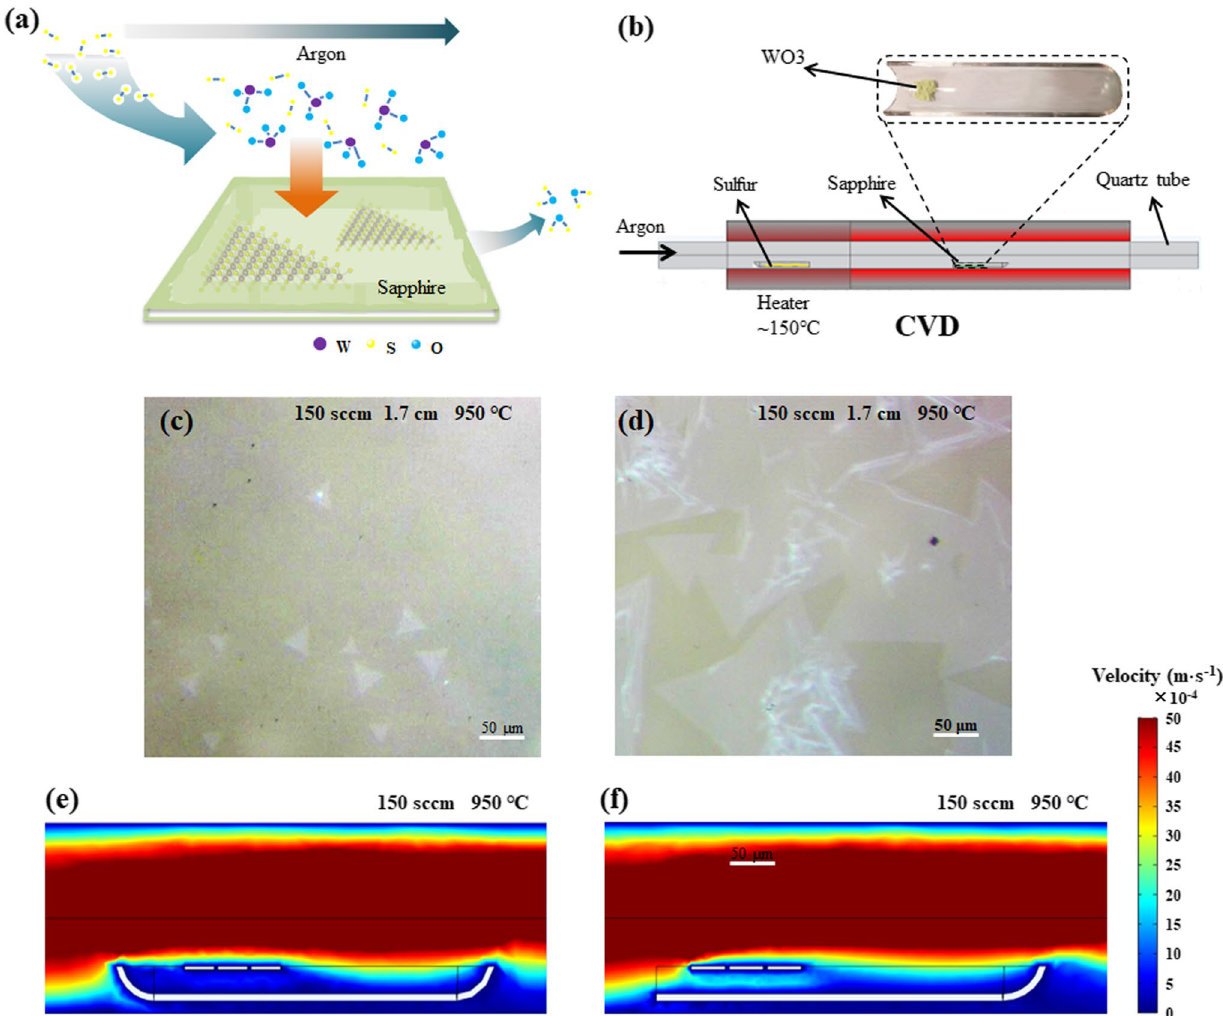
Fig. 1 Schematics of a the related chemical reaction and b CVD system (the inset is the scenery of the sapphire and WO quartz boat). c – d The optical images of as-grown WS on sapphire substrates with traditional conventional quartz boat and front opening 2 quartz boat, respectively. e – f COMSOL simulation of gas distribution of traditional quartz boat and front opening quartz under the same conditions,